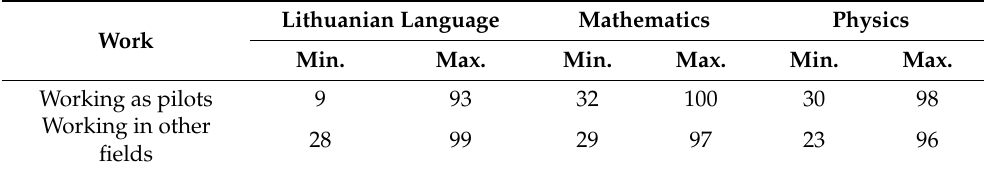
Table 3. Highest and lowest maturity examination scores of the graduates working as pilots and those working in other fields (source: created by the authors).